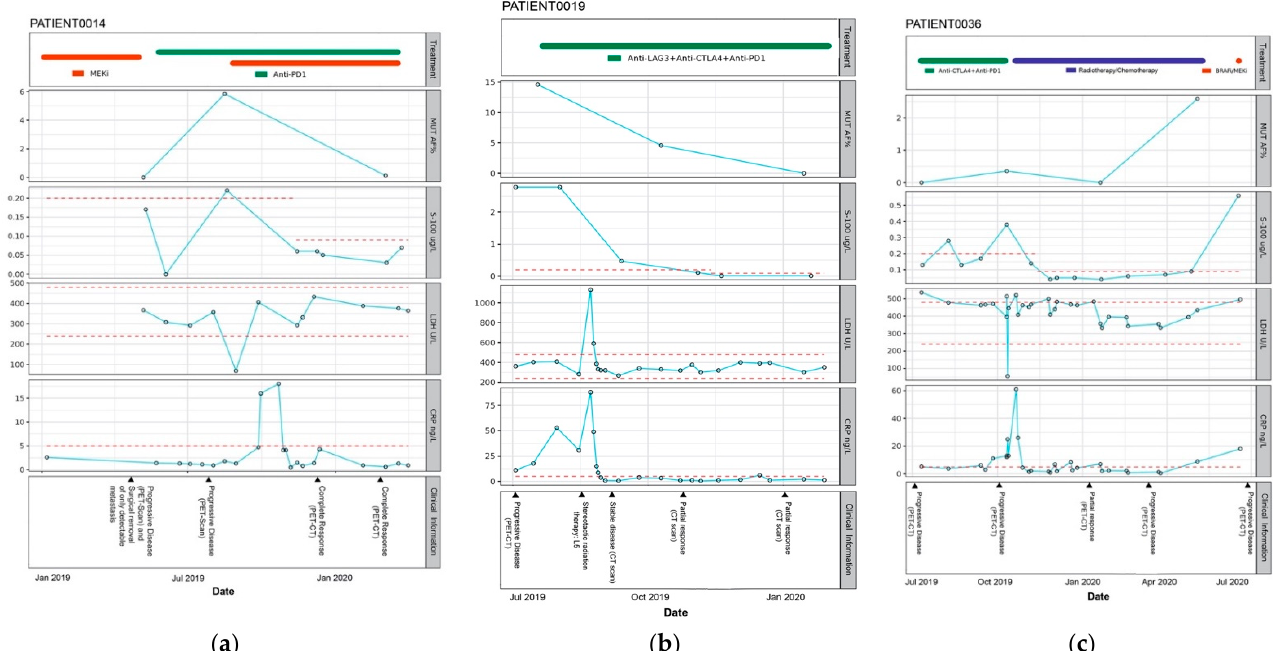
Figure A2. Longitudinal measurements of ctDNA, S100, LDH, CRP, Therapeutic Interventions, and PET-CT results over time in three patient examples. Dashed red lines: S100: ULN (Assay changed in December 2019, different ULN); LDH, ULN and 2× ULN; CRP, ULN ; Mut AF; Mutant Allele Frequency.